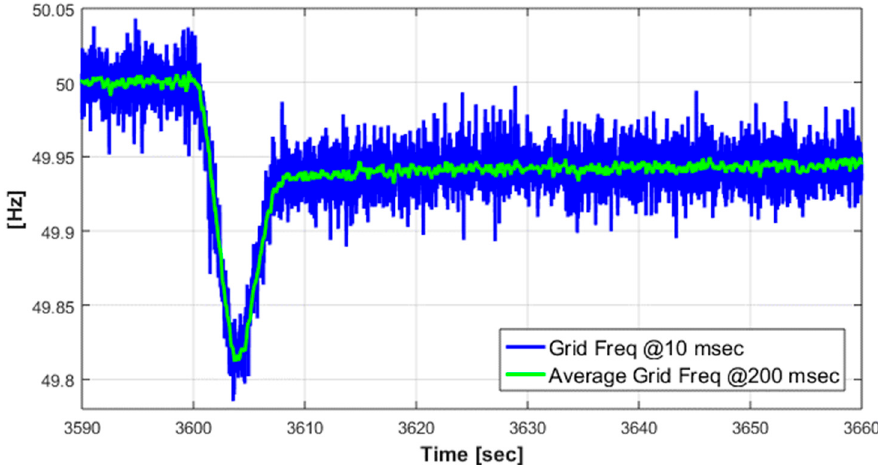
Figure 9. Realistic large frequency excursion provided by the grid frequency model.